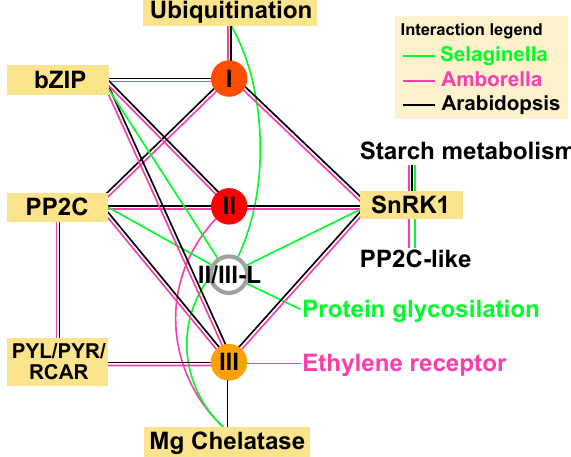
Figure 4. Network outline summarizing the known and predicted associations in the STRING networks for the Arabidopsis SnRK2s and their orthologs in Amborella and Selaginella . Most SnRK2 groups across the included species are related to the same processes and nodes highlighting bZIP transcription factors, ABA-related PP2C signaling and sensing and carbon metabolism. Some specific features also arose as the interaction of the Amborella SnRK2 III ortholog with an ethylene sensor or the interaction of the Selaginella sequences with elements related to the modulation of protein glycosylation. All connections shown in this outline are possibly conserved among PpiSnRK2 sequences taking into account the intermediate pine position between Arabidopsis , Amborella and Selaginella .